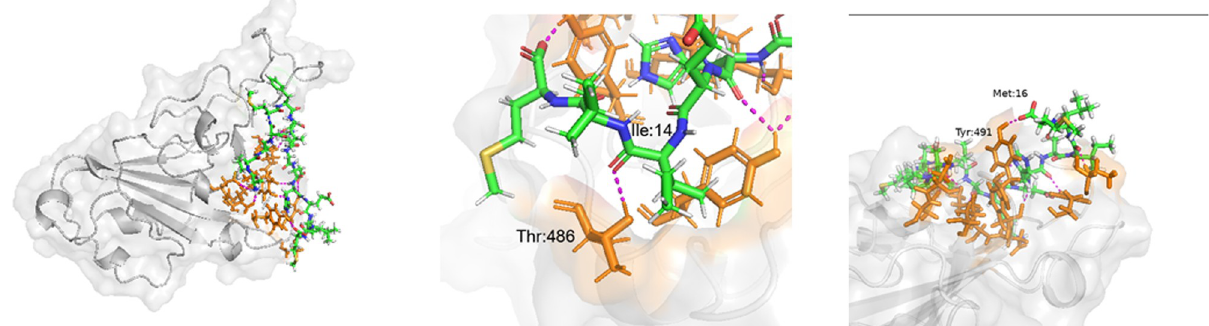
Fig 5. (a) Peptide 7-SARS-CoV RBD complex. Peptide 7 (green, blue and white liquorice), RBD (grey) and residues in RBD which interact with Peptide 7 are highlighted (orange liquorice). (b) Hydrogen bonding between Peptide 7 and RBD residues, Ile14 and Thr486 (c) Hydrogen bonding between Met16 and